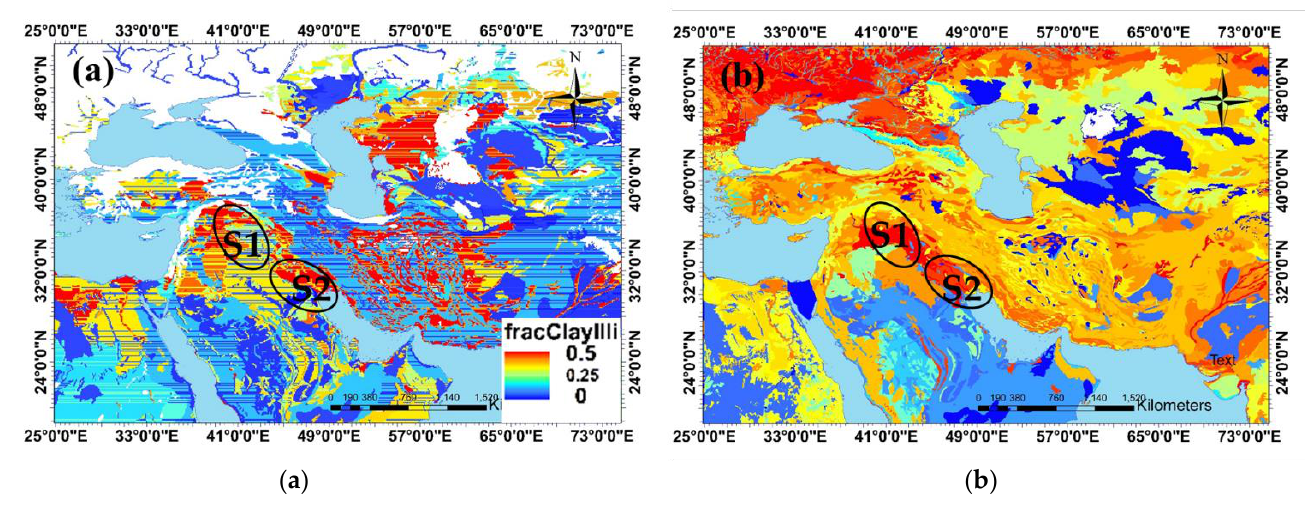
Figure 1. The clay ( a ) and silt fractions ( b ) of dust aerosols at emissions for the soil mineral fraction (SMF) method in the Middle East region (S1 and S2 are dust sources).